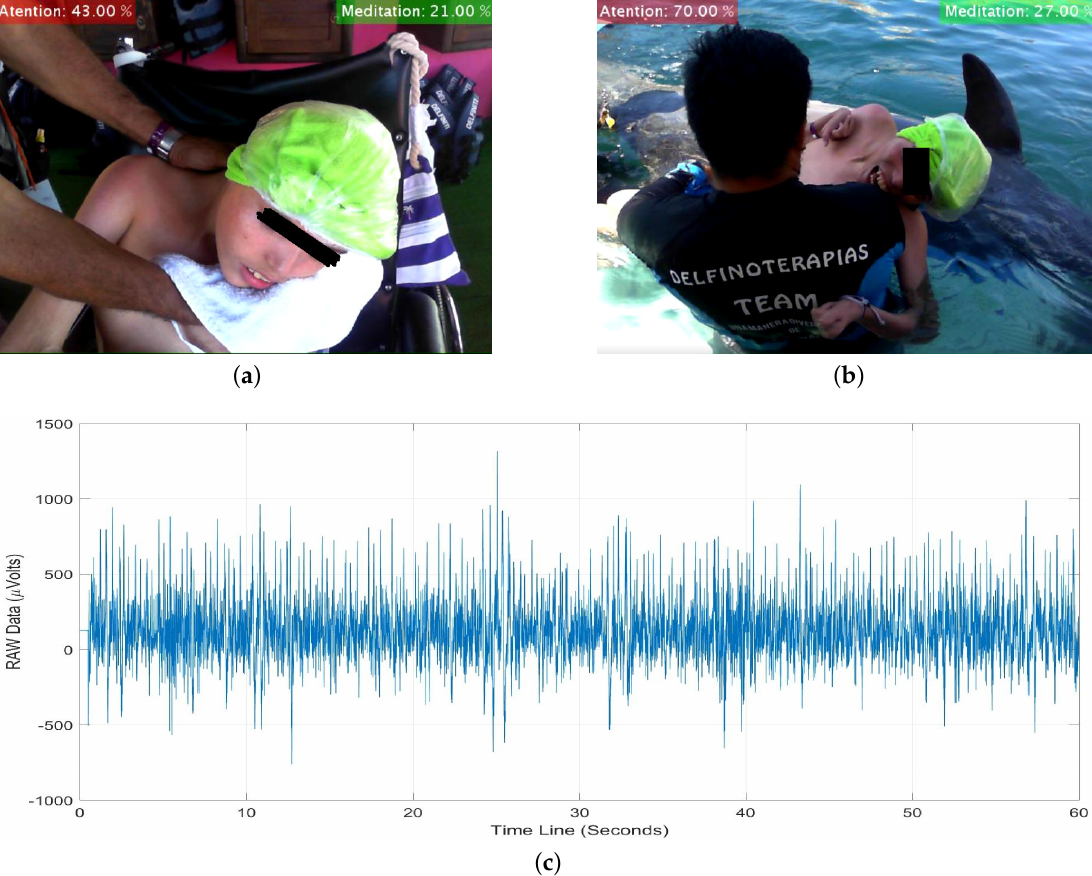
Figure 21. Acquisition of Time Series or RAW samples from EEG M . ( a ) Before DAT, ( b ) during DAT, and ( c ) Example of generated time